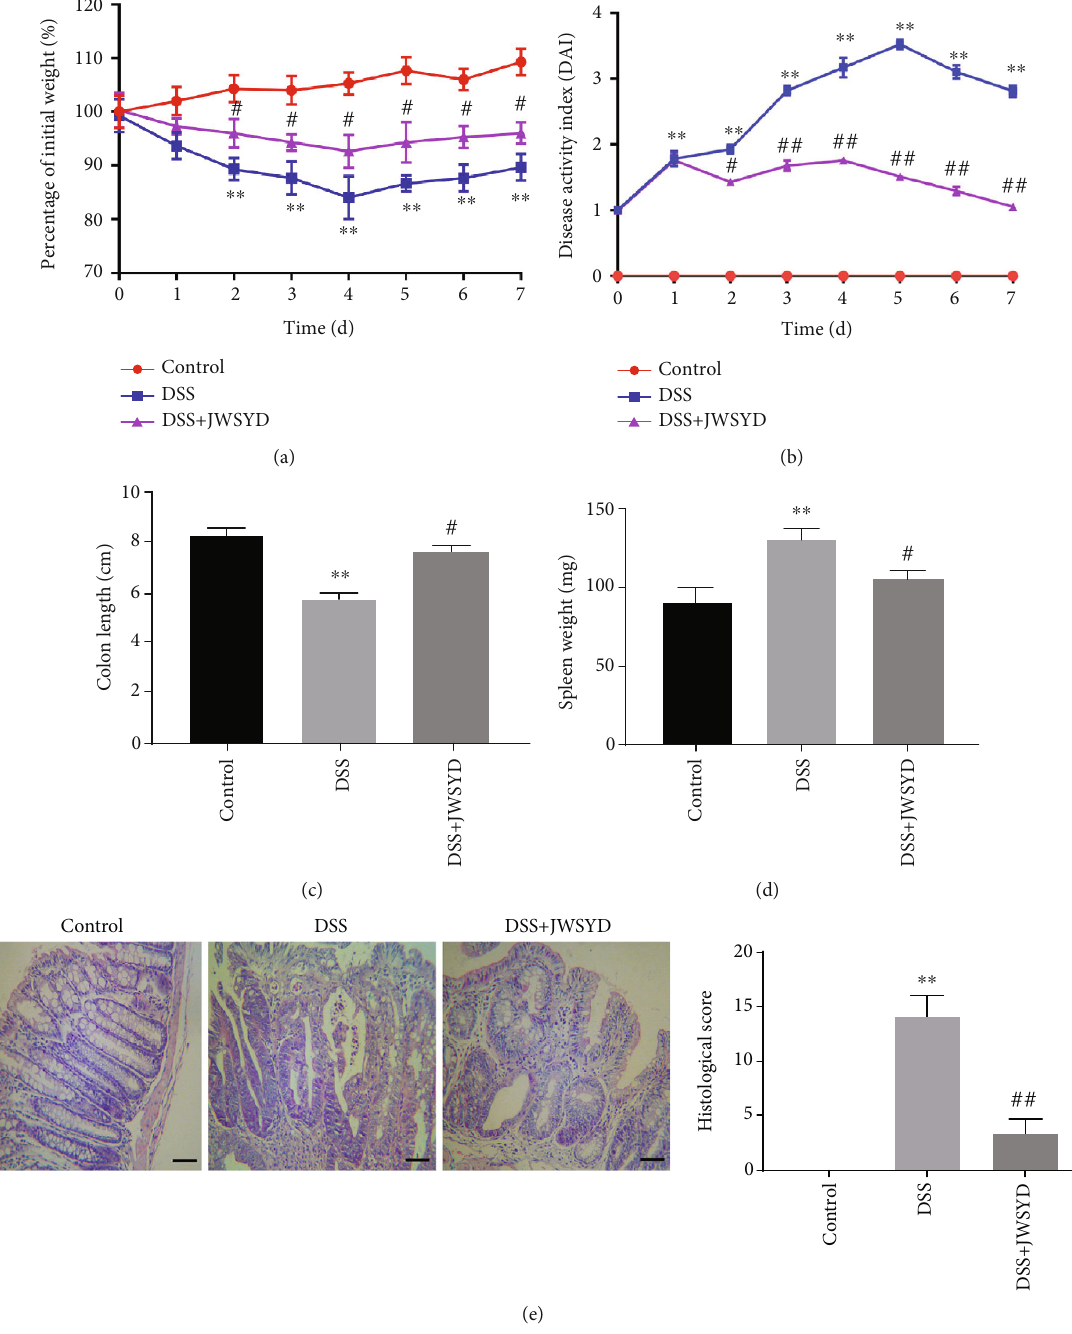
Figure 1: Jiaweishaoyao decoction (JWSYD) improved the DSS-induced ulcerative colitis (UC) in mice. (a) The percentage of initial weight from 0 to 7 days. (b) Disease activity index (DAI) from 0 to 7 days. (c) Colon length. (d) Spleen weight. (e) HE staining and histopathological score (magni fi cation × 400). Bar = 100 μ m. ∗∗ P < 0 : 01 compared with the control group; # P < 0 : 05 , ## P < 0 : 01 compared with the DSS